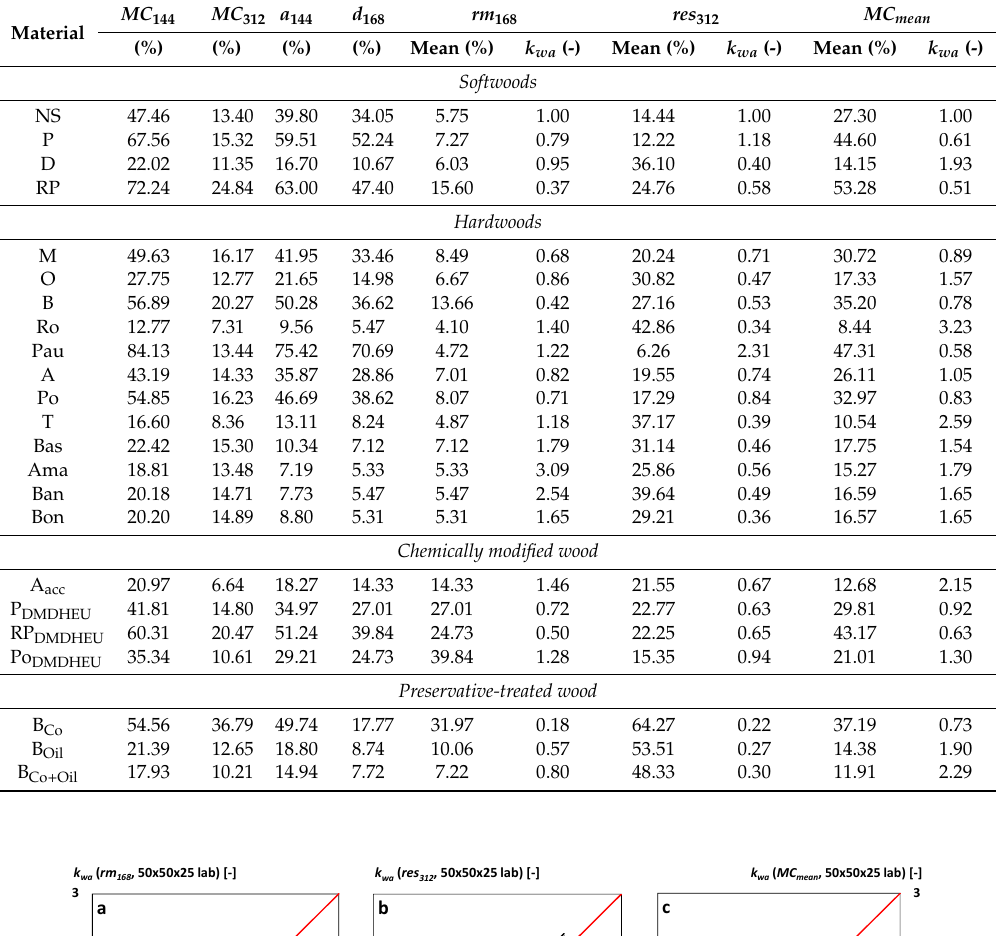
Table 5. Moisture content at the end of absorption ( MC 144 in %) and desorption cycle ( MC 312 in %), amount of absorbed moisture after 144 h ( a 144 in %), amount of desorbed moisture after 168 h ( d 312 in %), residual moisture content ( rm 168 in %), residue ( res 312 in %) and mean MC ( MC mean ) in submersion tests (150 (ax.) × 50 × 25 mm 3 ) according to [5]).